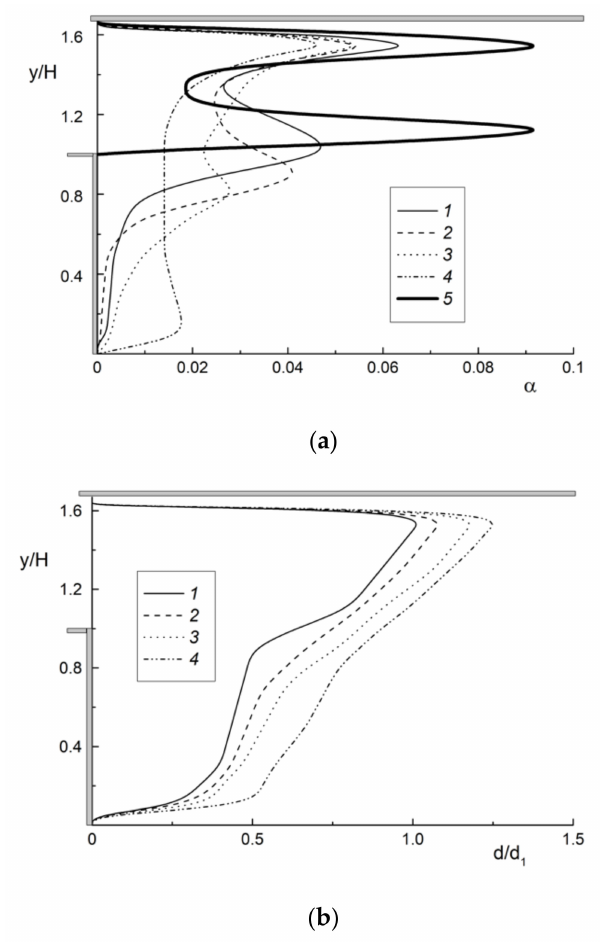
Figure 10. The transverse profiles of total local void fraction ( a ) and bubble diameter ( b ) along the duct length in the upward bubbly flow behind the backward-facing step. Re H = 6600, ER = 2.5, β = 3%. ( a ): 1— x / H = 0, 2—2, 3—4, 4—6, 5—10; ( b ): 1— x / H = 2, 2—4, 3—6,